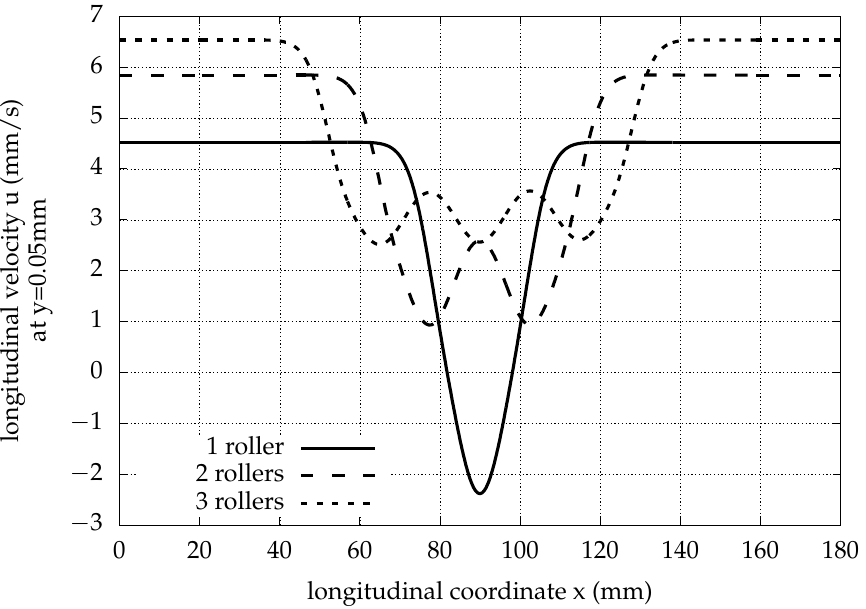
Figure 14. Longitudinal velocity near the central axis of the pump ( y = 0.05 mm) for various numbers of rollers. The roller speed is c = 5 mm/s, the relative occlusion is RO = 0.6 and the Bird–Carreau power index is n =